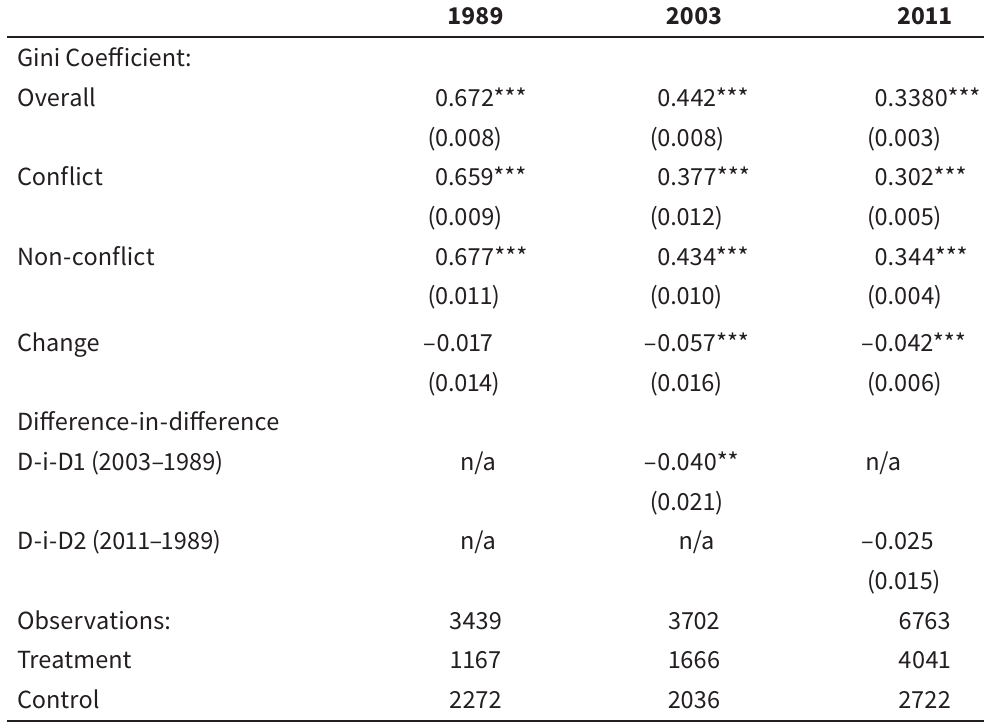
Gini Coefficient for Household Expenditure by Conflict Exposure